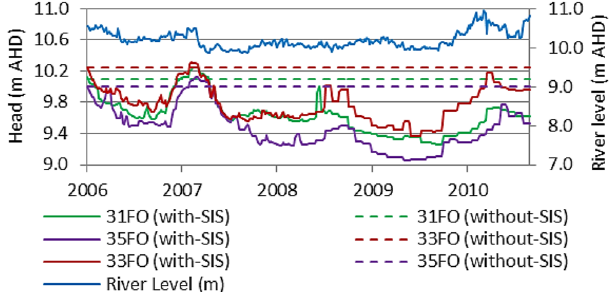
Fig. 8. Changes in water storage in the porous media for the defined scenarios (light blue pattern refers to the period that the pumps were in